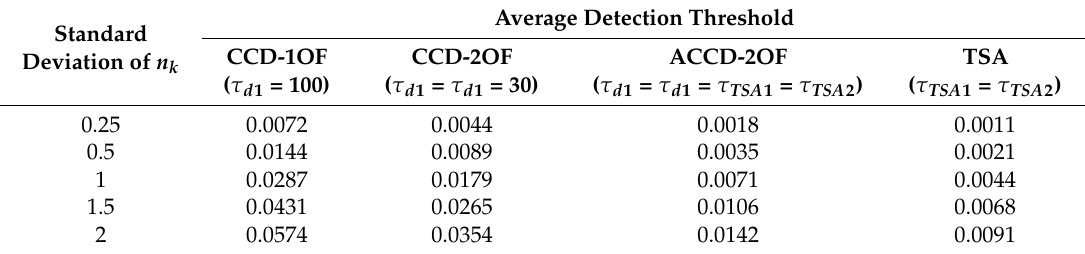
Table 2. Comparing the detection sensitivity of four methods in different standard deviations of